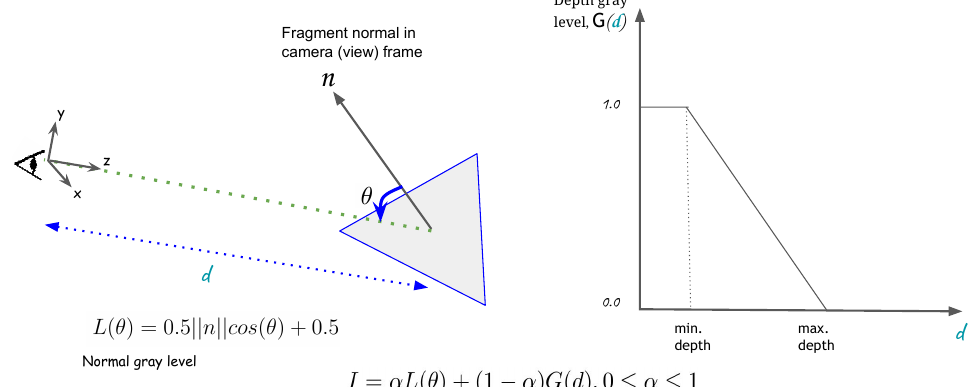
Figure 1. Simple shading for fast rendering based on fragment normal n and fragment depth d . L ( θ ) is the component of fragment’s intensity in render due orientation θ of n relative to render camera’s optical axis, and G ( θ ) that due to its depth. Final intensity in render, I , is an affine combination of the two, with manually chosen α , which is the same for all fragments. I is also varied based on whether the fragment belongs to CAD of inspection element or that of assembly on which it is